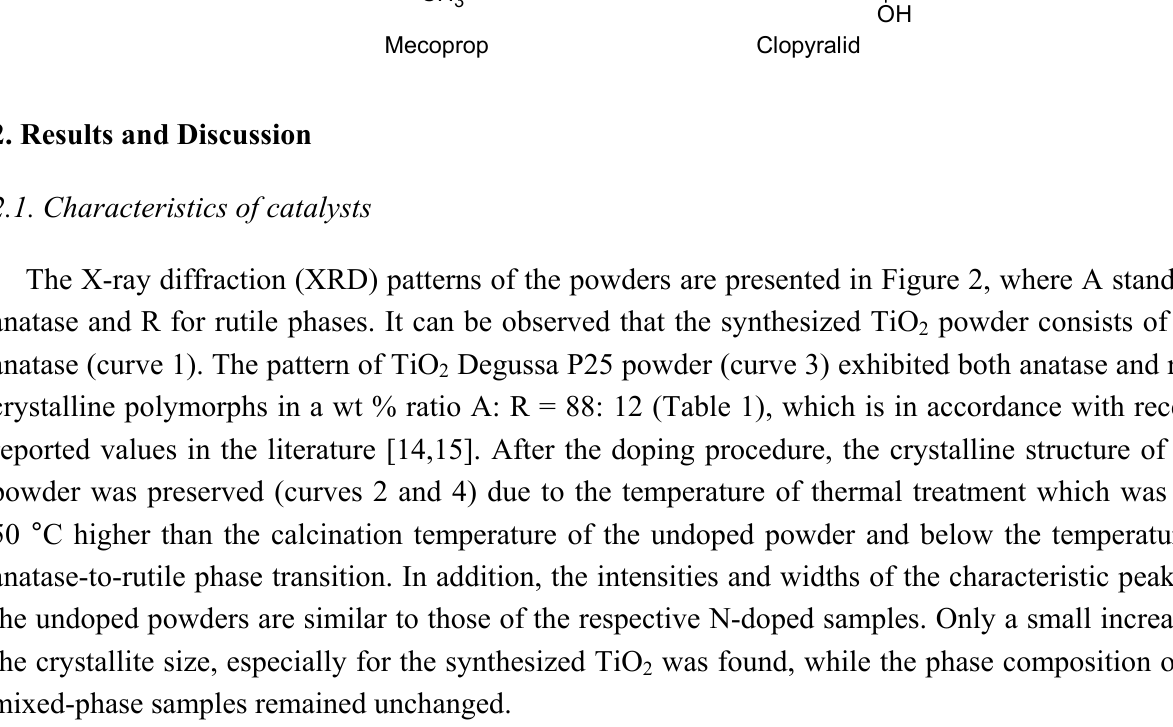
Figure 2. XRD patterns of undoped and urea-modified TiO